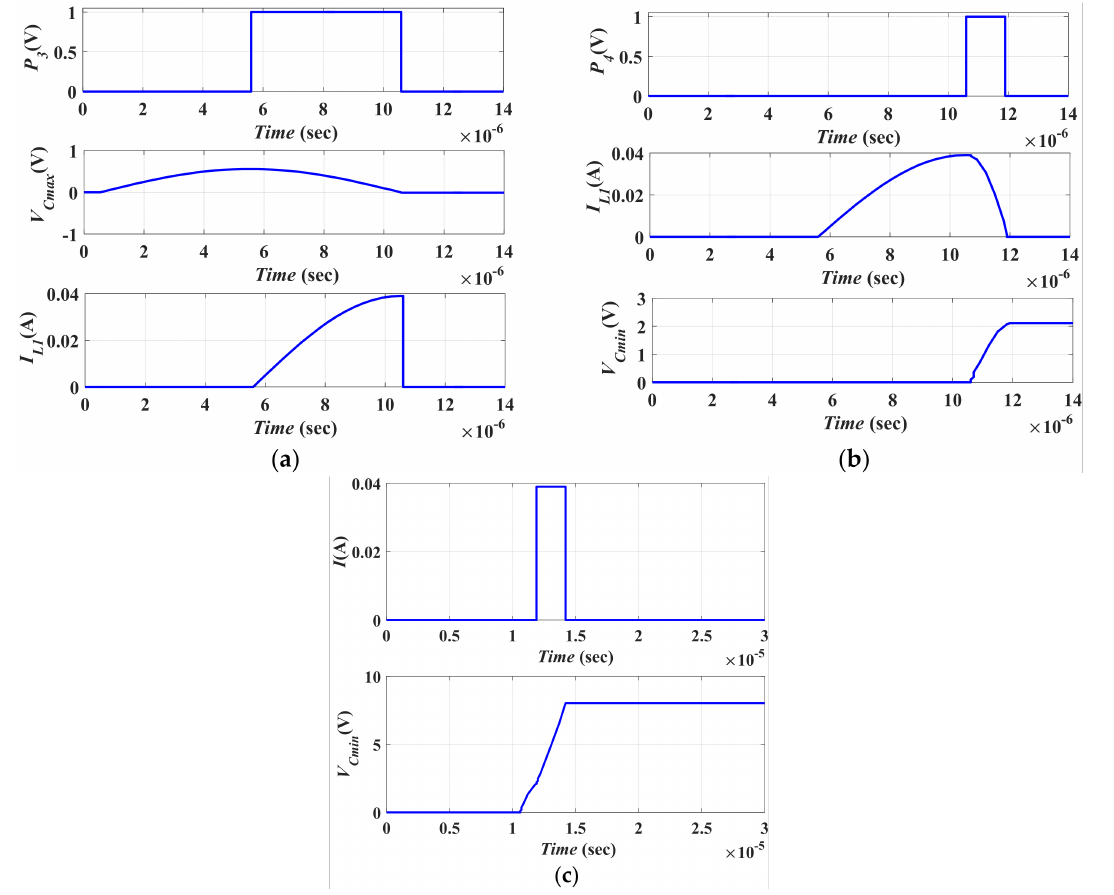
Figure 12. The second stage simulation results ( a ) The Simulation result of P 3 , and the charging current of and L 1 , ( b ) Charging of C min from L 1 during PW 4 through S 2 , and ( c ) Boosting V Cmin to V max by the effect of I